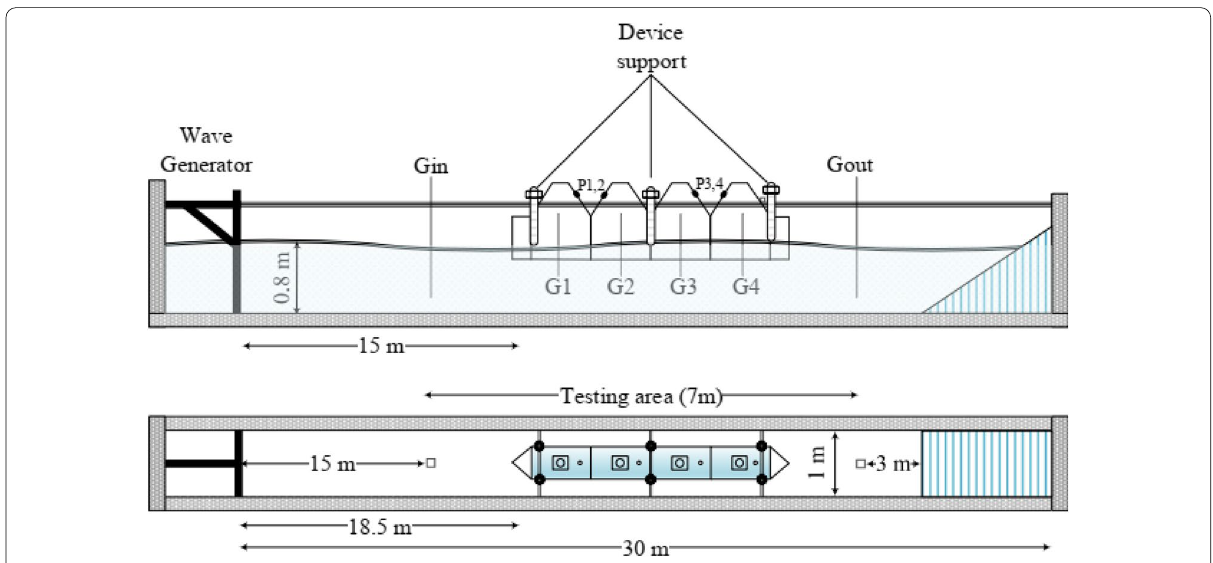
Figure 1 Front and top views of the experimental setup (not drawn to